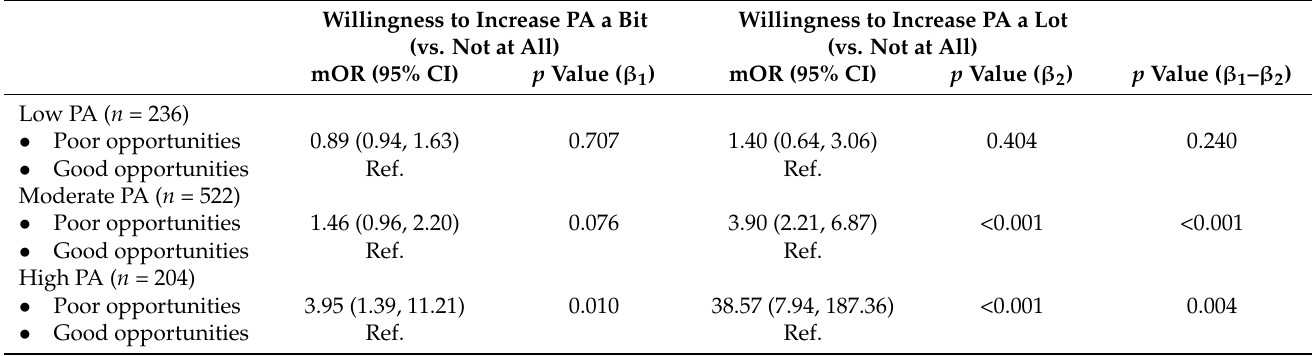
Table 4. Association between opportunities and willingness to increase physical activity within physical activity levels. Results of the moderation model with levels of physical activity moderating the effect of poor opportunity (vs. good) on willingness to increase physical activity a bit or a lot (vs. not at all) ( n =